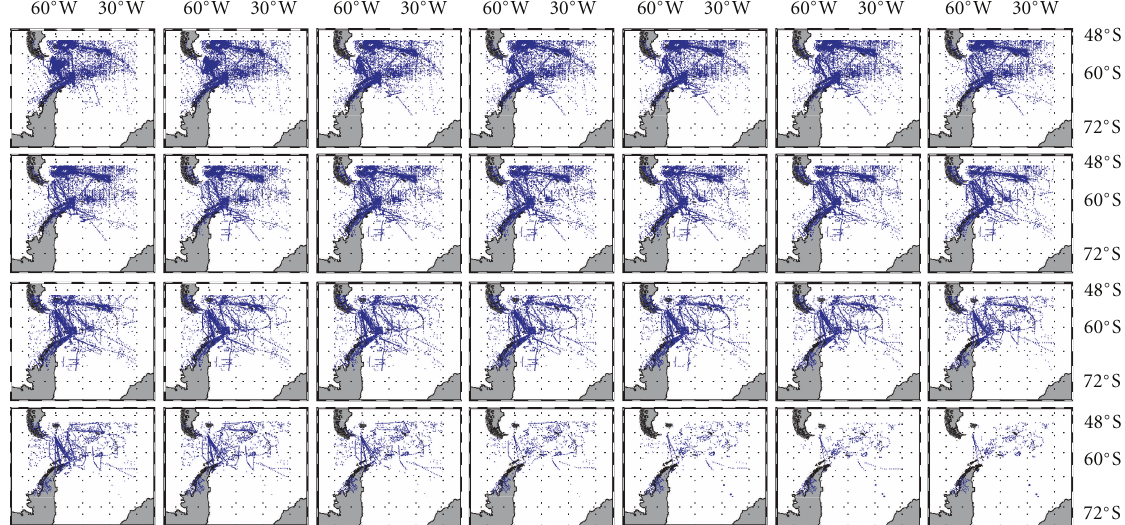
Figure 3: Stations used for T-S diagrams shown in Figure 2. Each panel presents January–March data for the period 1975–2002. These stations include measurements by various instruments shown in Table